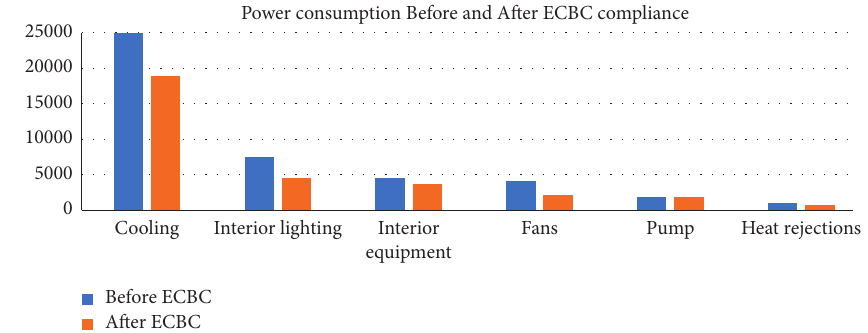
Figure 7: Comparison of power consumption by various category loads before and after incorporation of ECBC